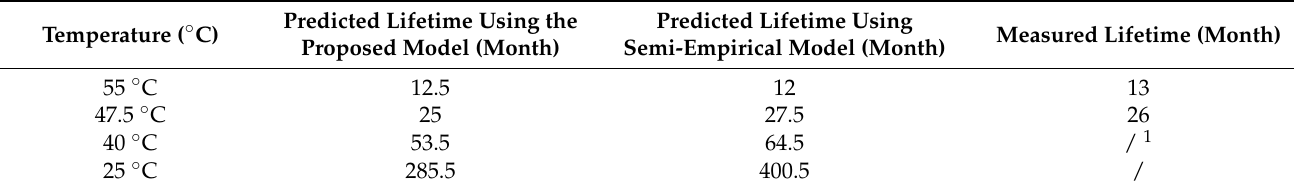
T R Figure 22. Arrhenius equation for determining the temperature dependence of resistance increase (at 50% SOC level).